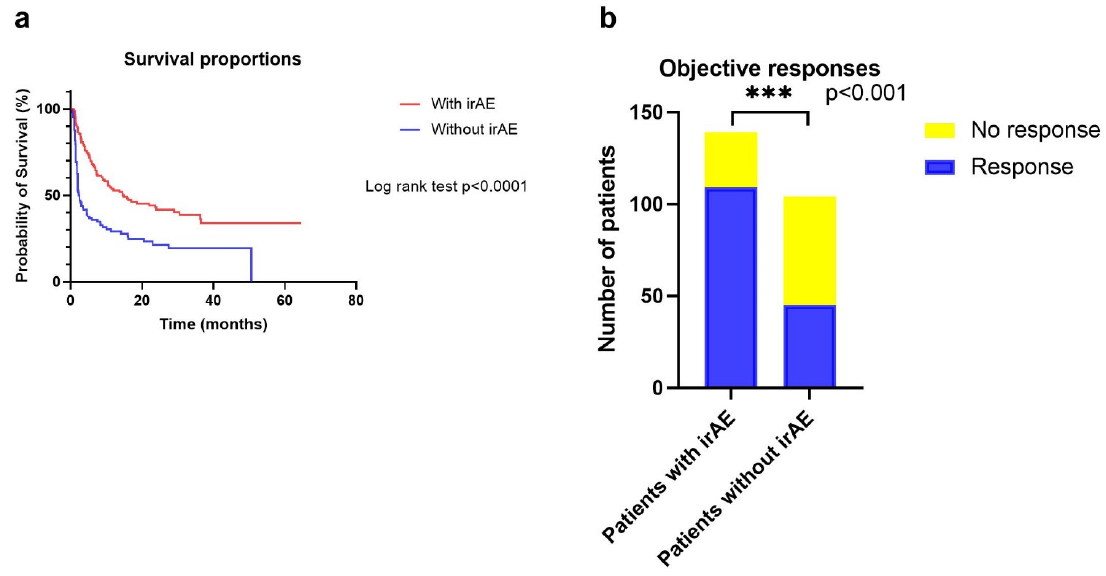
Figure 3. Correlations between irAEs and PFS ( a ) and ORR ( b ). Log-rank tests were used to evaluate survival differences. Chi-square tests or Fisher exact tests were used to make intergroup comparisons. *** p <